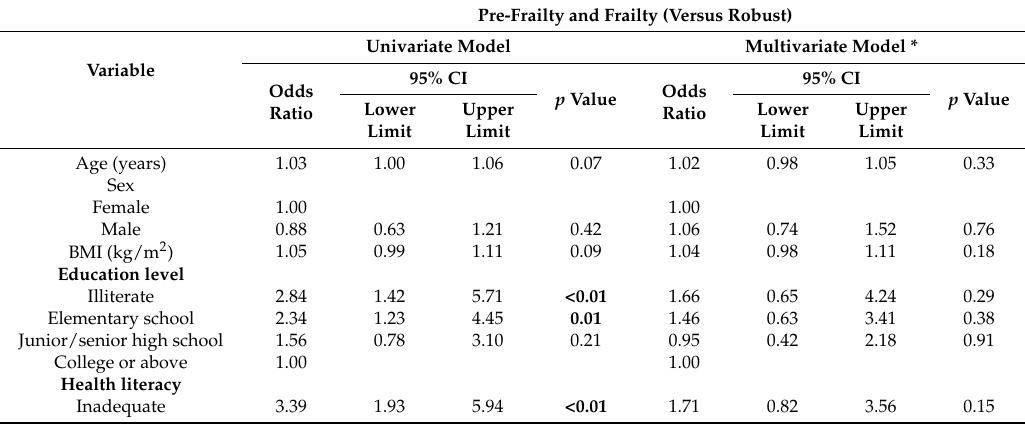
Table 3. Risk factors for pre-frail and frail status by odds ratio in logistic regression